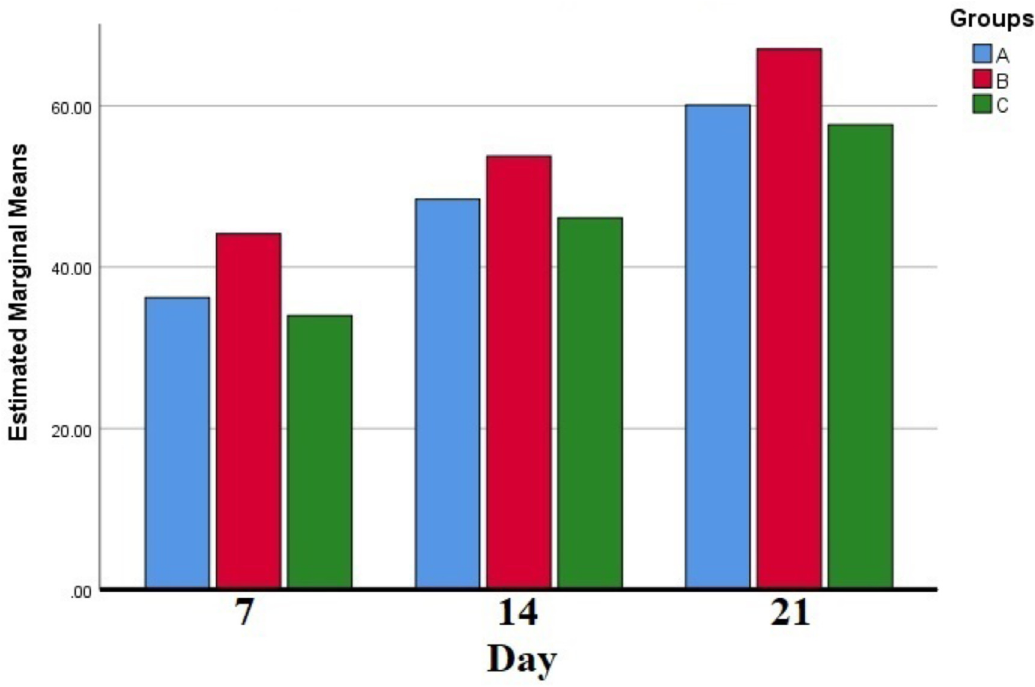
Fig. 6. Estimated marginal means of percentage of bone trabeculae on day 7, 14, and